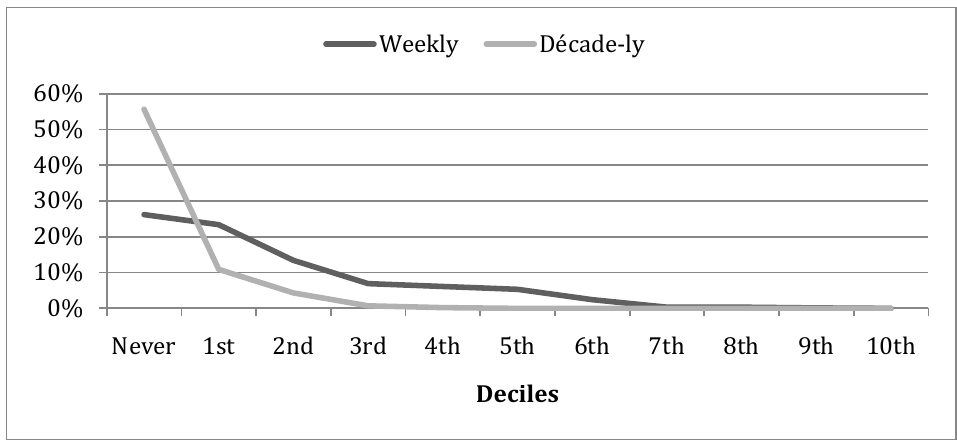
Figure 2. Distribution in deciles of keys charged weekly and